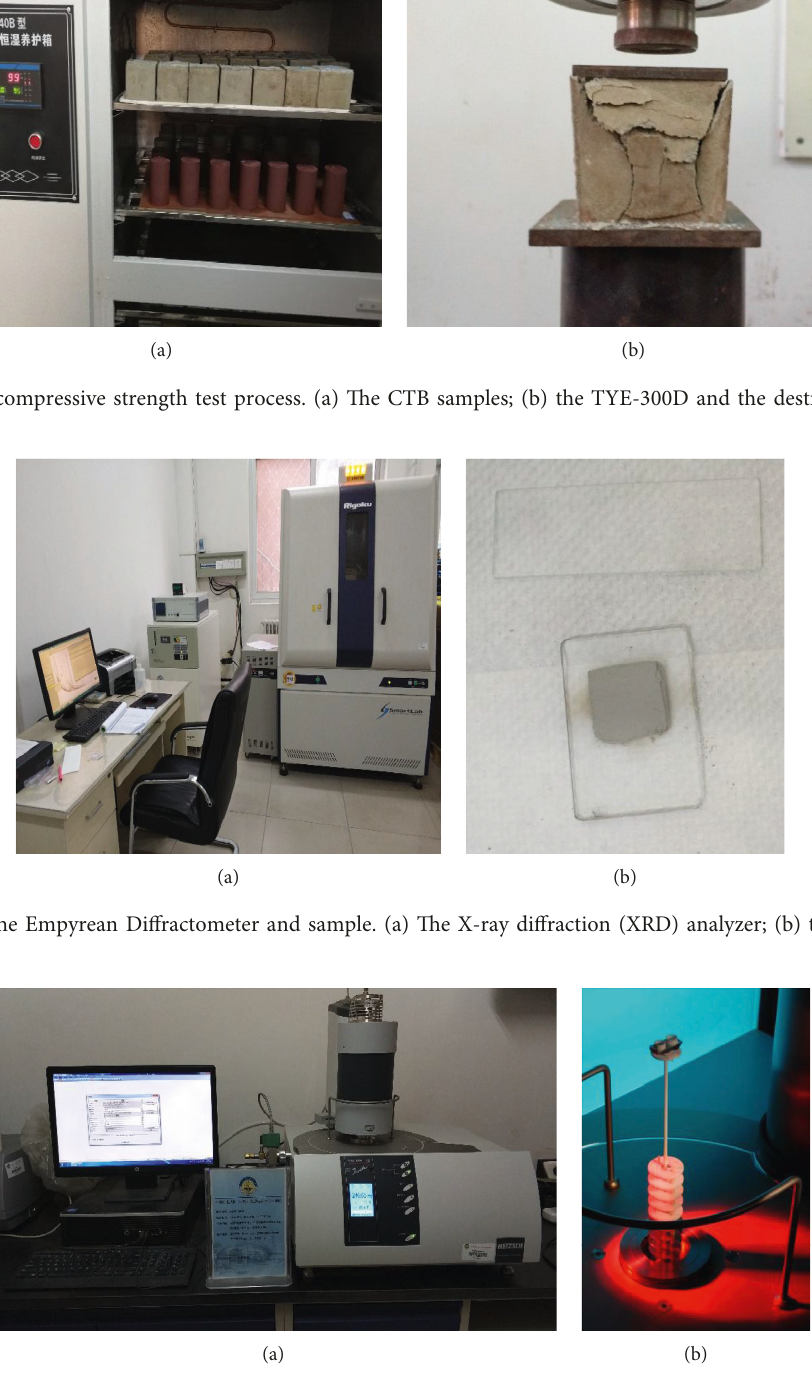
Figure 3: STA449F3 and sample carrier. (a) STA449F3 thermal analyzer; (b) sample